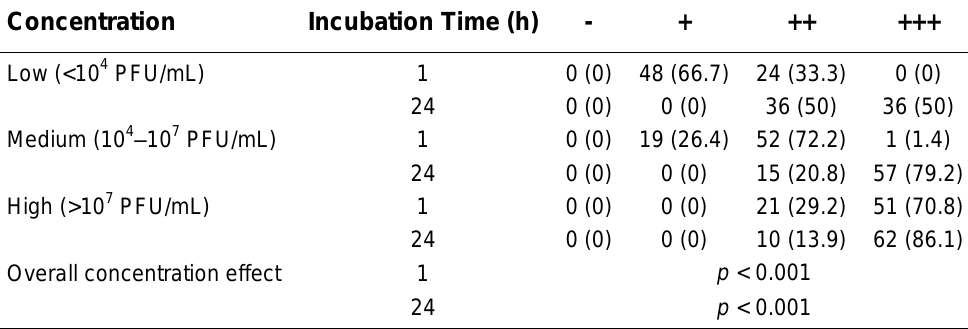
Antibacterial Activity of Different Phage Concentrations against Resistant Klebsiella spp. after 1 and 24 h of Incubation in the Tube Method